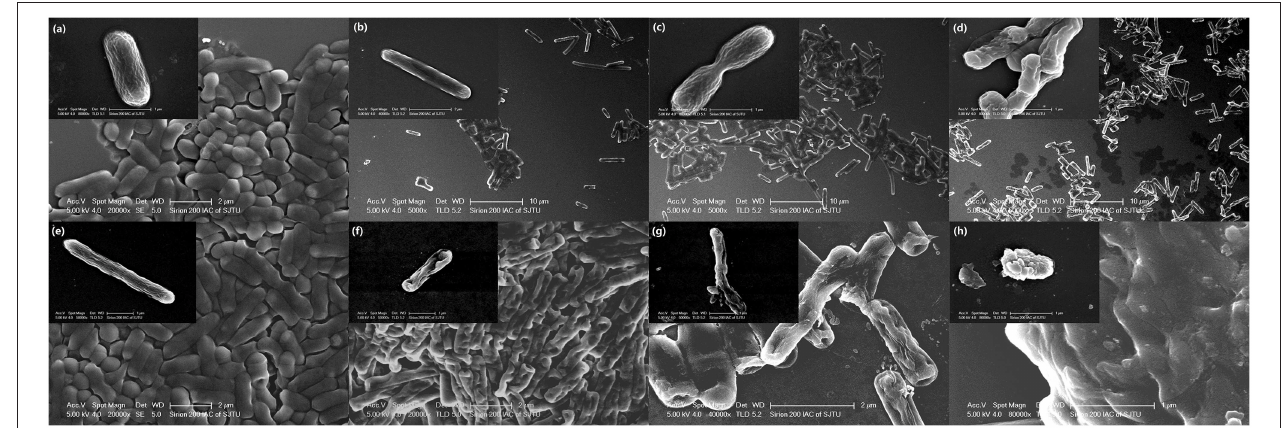
FIGURE 4 | Morphology of C. difficile ATCC 9689 observed by scanning electron microscopy. (a–d) : Control at 0, 1, 2, and 3h; (e–h) : treated with YH68-CFCS for 0, 1, 2, and 3h.